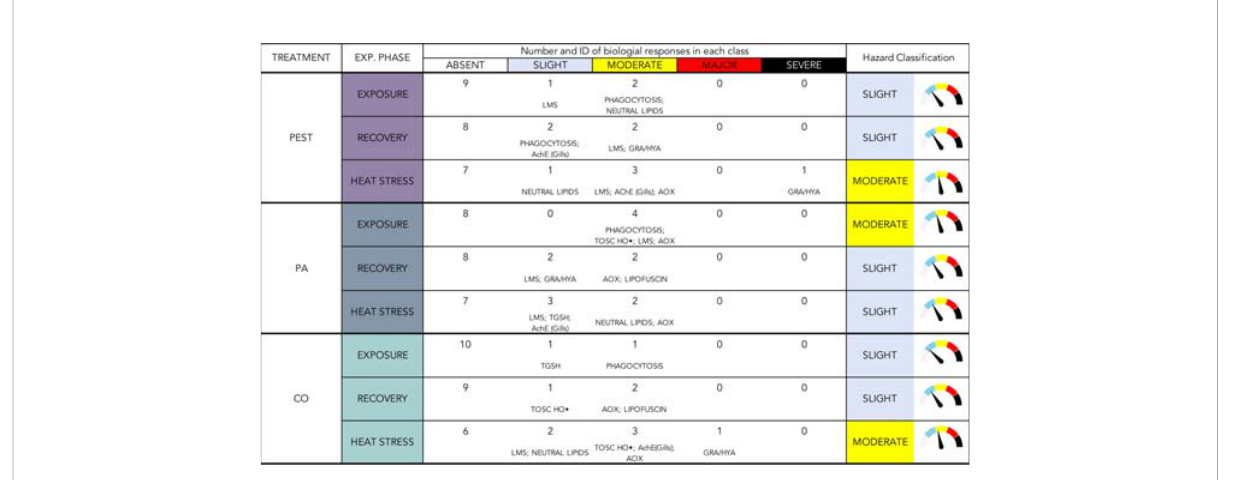
FIGURE 7 Weighted elaboration of collected results for each experimental treatment in each experimental phase. Number and identi fi cation (ID) of biological responses in each class are given, together with the overall hazard classi fi